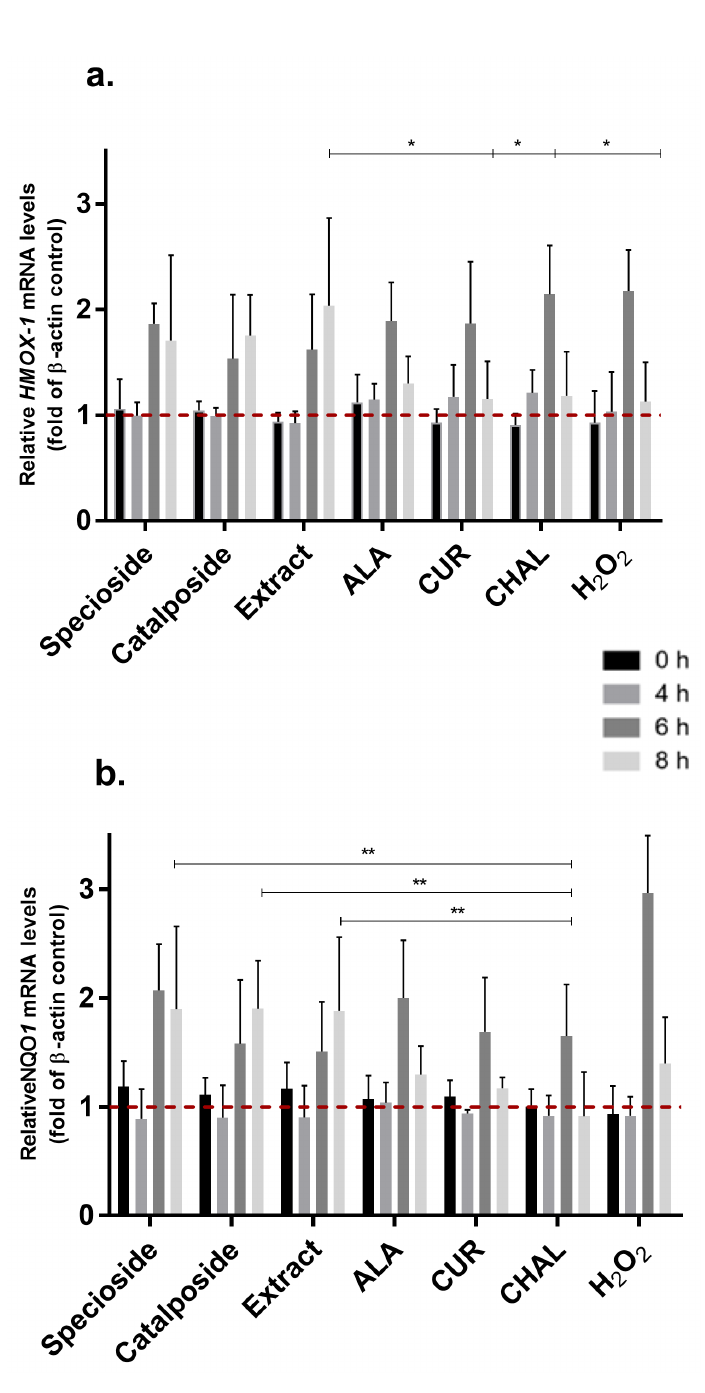
Figure 5. Relative HMOX-1 ( a ) and NQO1 ( b ) mRNA levels after 0, 4, 6 and 8 hours post-exposure to 2 µM (pure compounds), 1 µg/mL ( n -butanol extract) and 0.98 mM (H